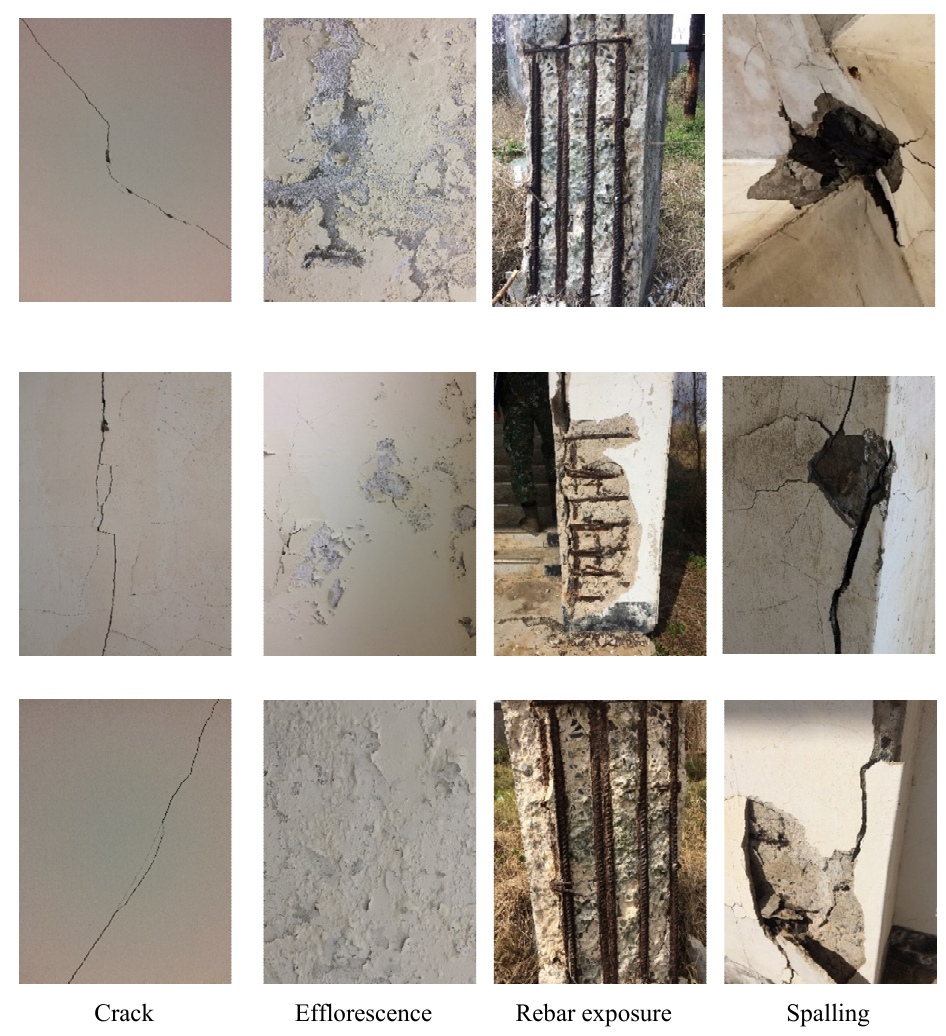
Figure 3. Four classes of images of RC damage.